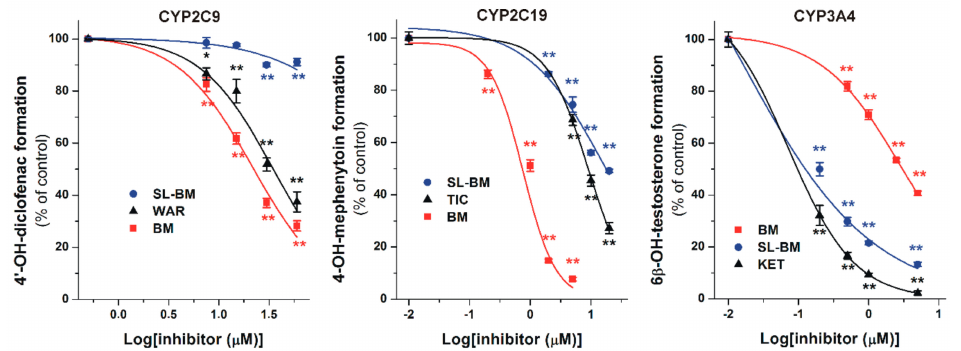
Figure 2. Concentration-dependent inhibitory e ff ects of BM, SL-BM, and positive controls